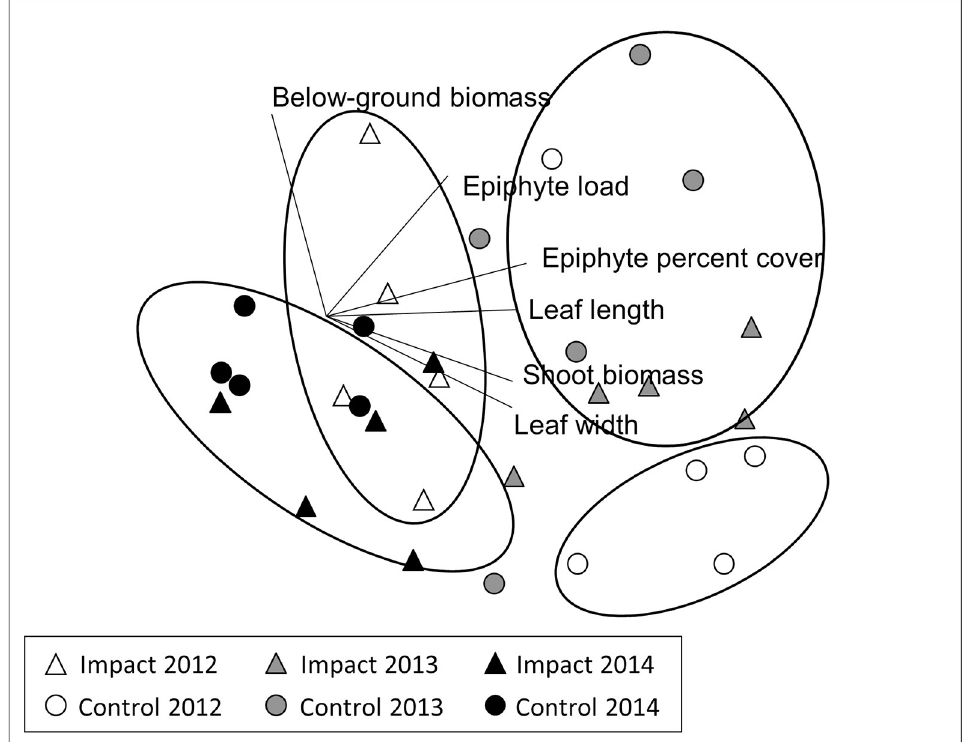
Fig 5. Non-metric multidimensional scaling plot illustrating variation in eelgrass characteristics between locations over time. Non-metric multidimensional scaling plot constructed from a similarity matrix based on Euclidean distance of the transformed data between the control (circle) and impact (triangle) locations across years: 2012 (white), 2013 (gray) and 2014 (black). Vectors represent Pearson correlations between variables and ordination axes, with the length and direction corresponding to the strength and sign of the correlation. Circles are drawn to indicate the pairwise test results (S3 and S4 Tables). 2D Stress: 0.14.